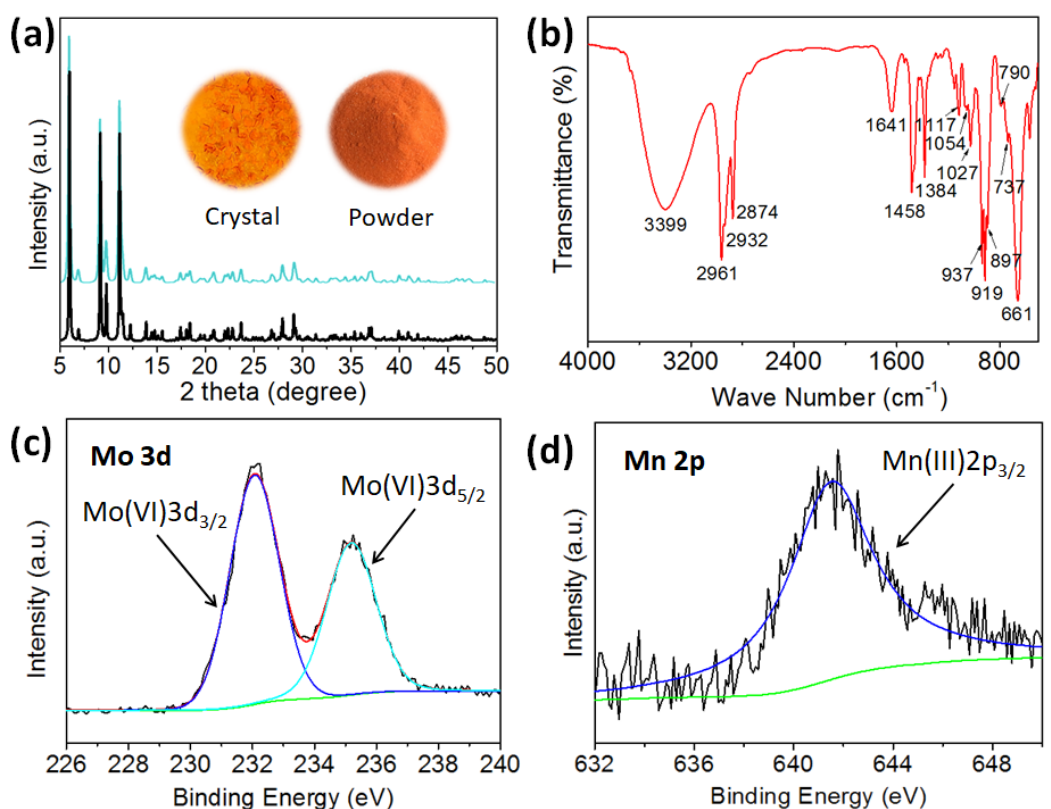
Figure 2. ( a ) XRD patterns (inset: digital photos, crystal and powder) of catalyst 1 (black, simulated XRD pattern of single crystal XRD of catalyst 1 ; blue, powder XRD pattern of compound 1 ); ( b ) The IR spectrum of catalyst 1 ; ( c , d ) The XPS spectra of ( c ) Mo3d and ( d ) Mn2p for catalyst 1 .